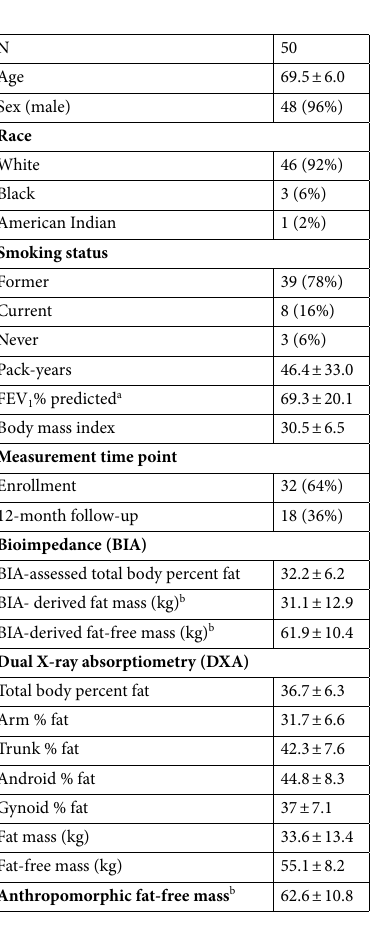
Table 1. Cohort characteristics. Data are expressed as n (%) or mean ± standard deviation. BIA bioimpedance, DXA dual X-ray absorptiometry, FEV 1 forced expiratory volume in the first second. a n = 48, b n = 47 due to missing anthropomorphic